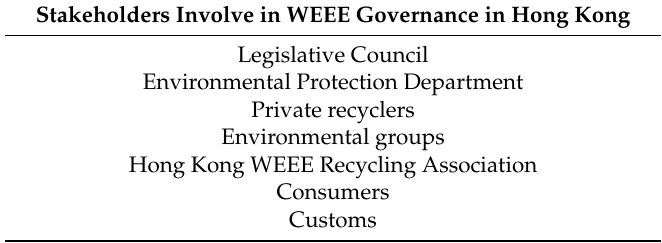
Table 1. Stakeholders involve in WEEE governance in Hong Kong.